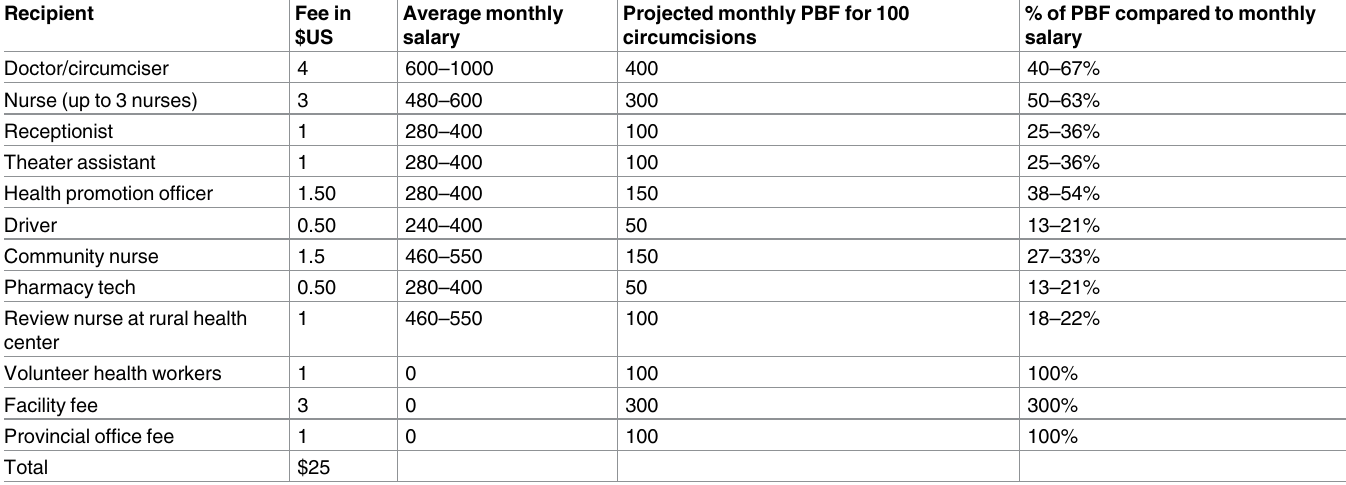
Table 1. MOHCC fee for servicestructure, 2015, and averageHCW